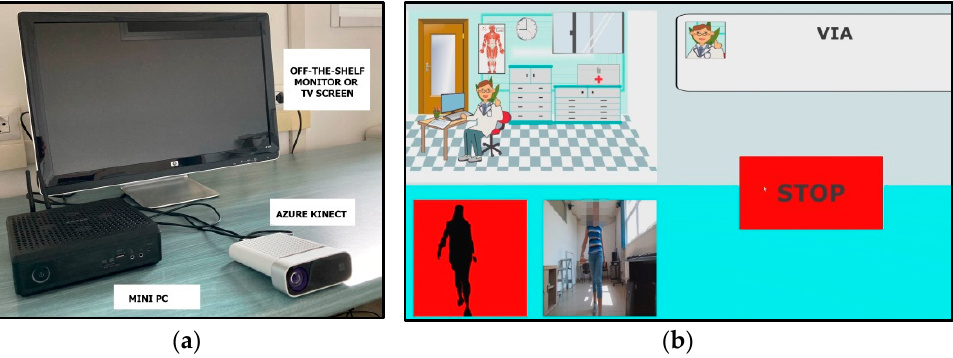
Figure 1. ( a ) The proposed system with the mini-PC, Azure Kinect, and a monitor; ( b ) GUI for the acquisition of gait